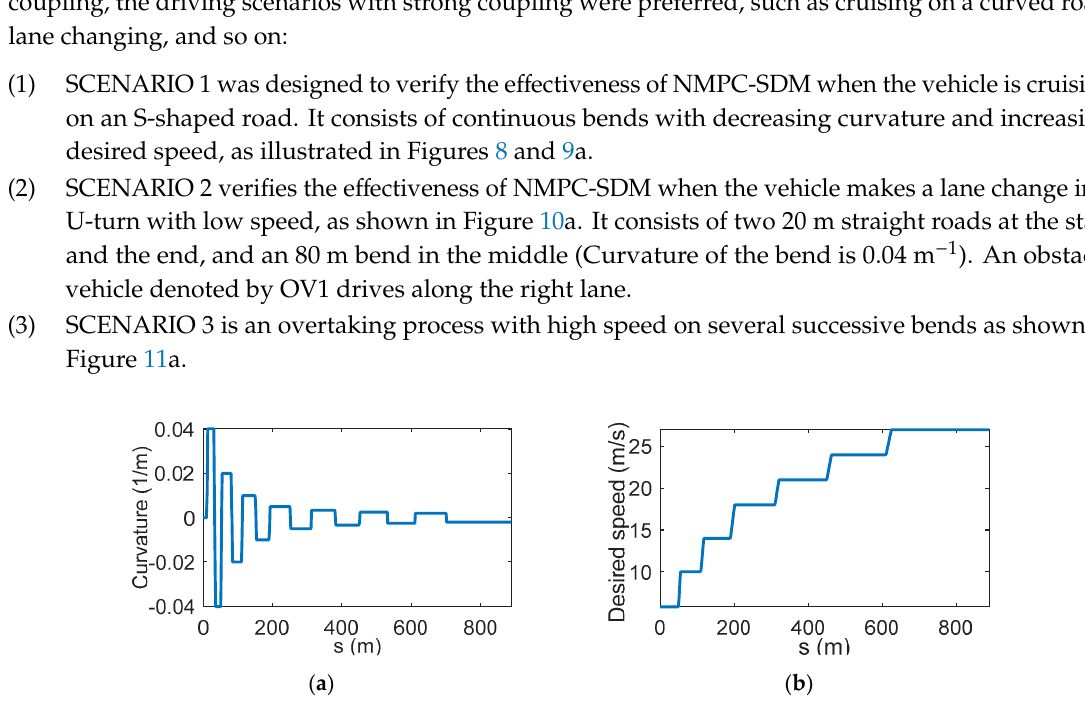
Figure 8. SCENARIO 1. ( a ) Curvature. ( b ) Desired speed. Table 2. Road parameters of SCENARIO 2 and 3.